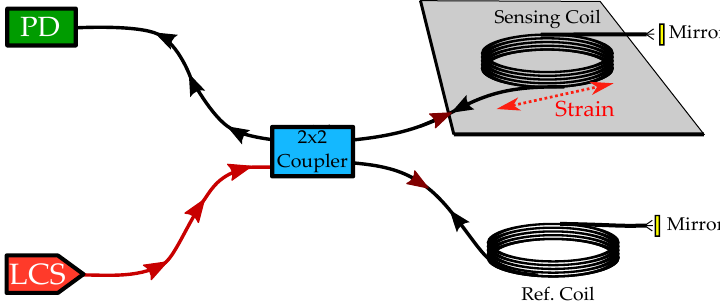
Figure 1. Fiber-optic Michelson interferometer for strain transduction. The sensing fiber coil is bonded to the specimen, which is strained by an elastic wave. The produced light from LCS and the light reflected at the fiber’s end are split/recombined in the